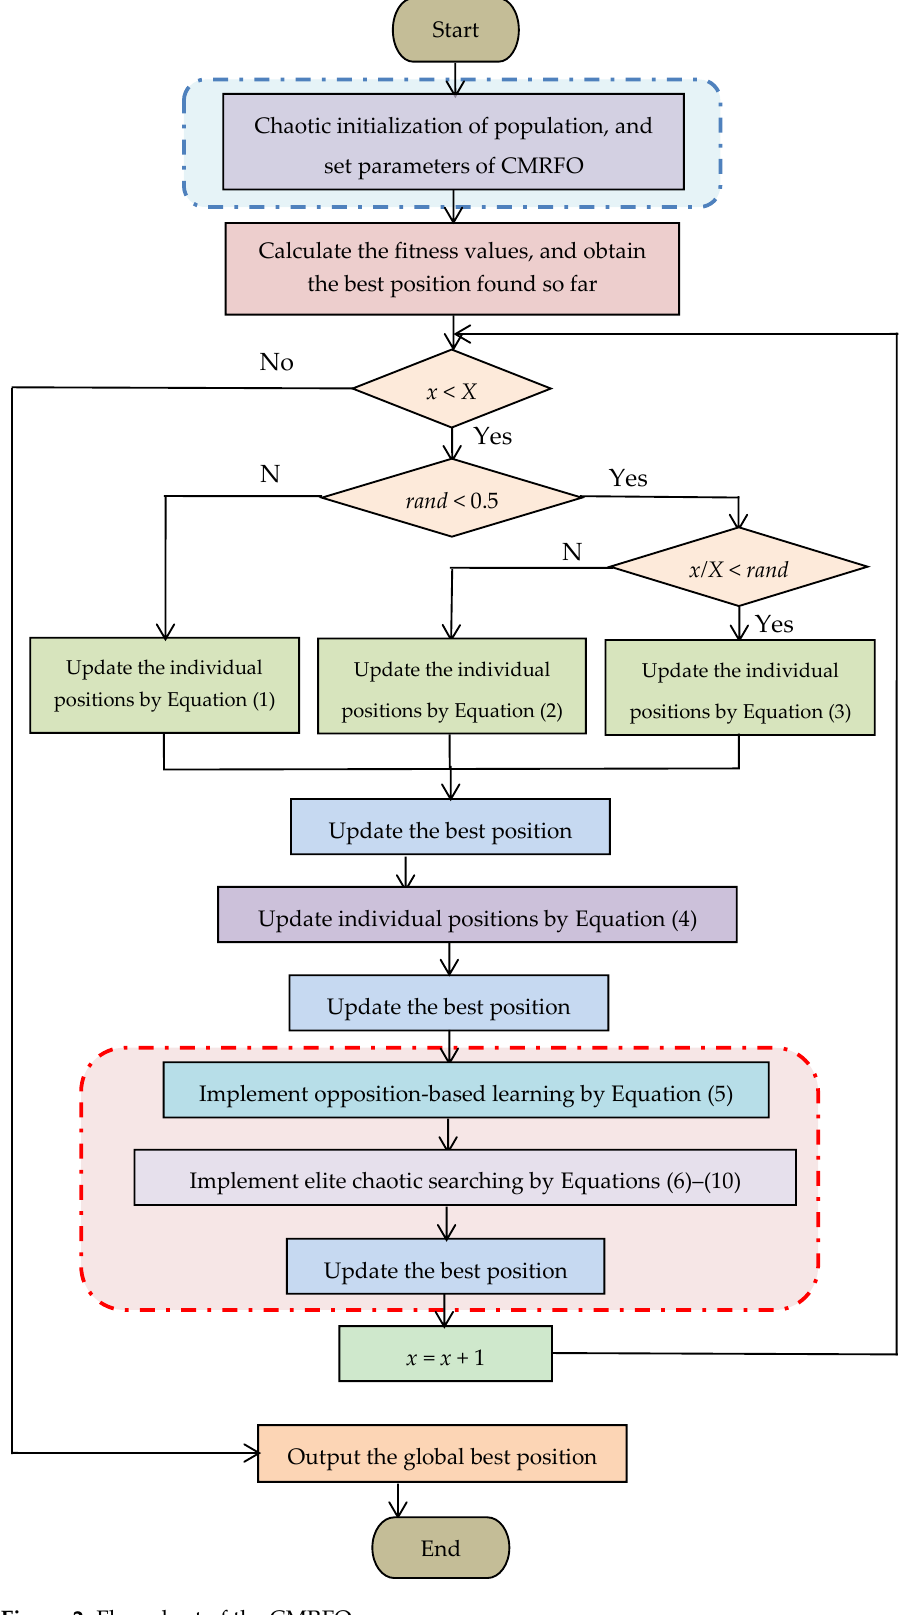
Figure 2. Flow chart of the CMRFO.